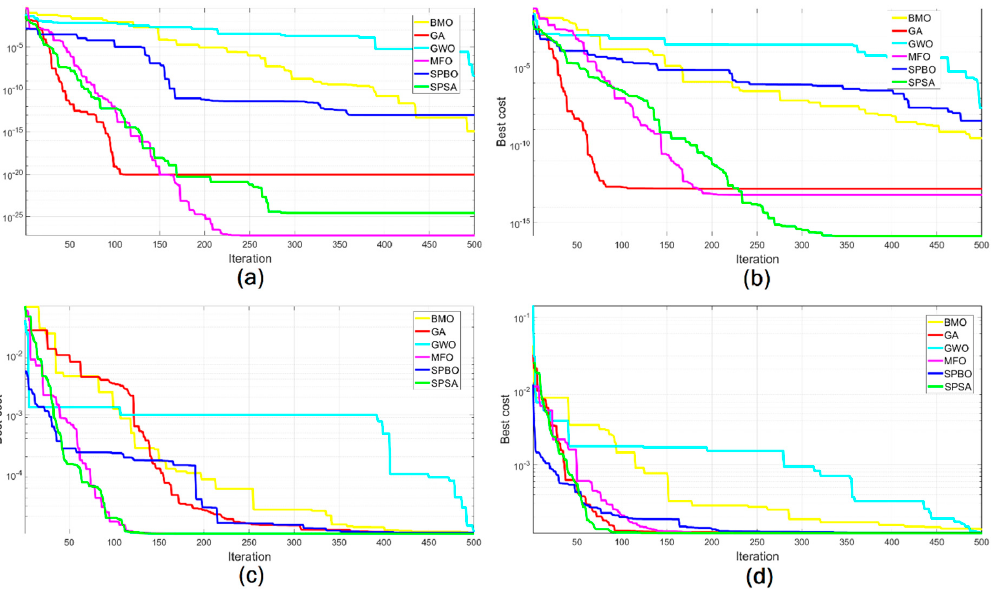
Figure 3. Convergence curves of the optimization algorithms for MLI with ( a ) 7 − level; ( b ) 11 − level; ( c ) 15 − level; and ( d ) 19 − level. ( c ) 15-level; and ( d )